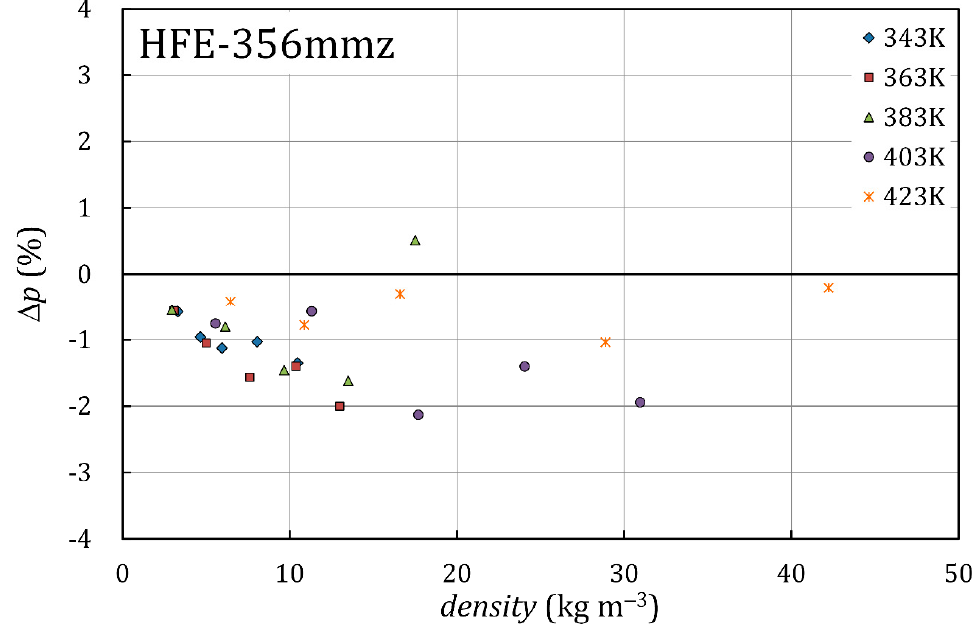
Figure 7. Pressure deviation of the present pressure-volume-temperature (PVT) data from the virial equation by Chen et al. [7] for HFE-356mmz. The base line corresponds to the pressure calculated from the virial equation.